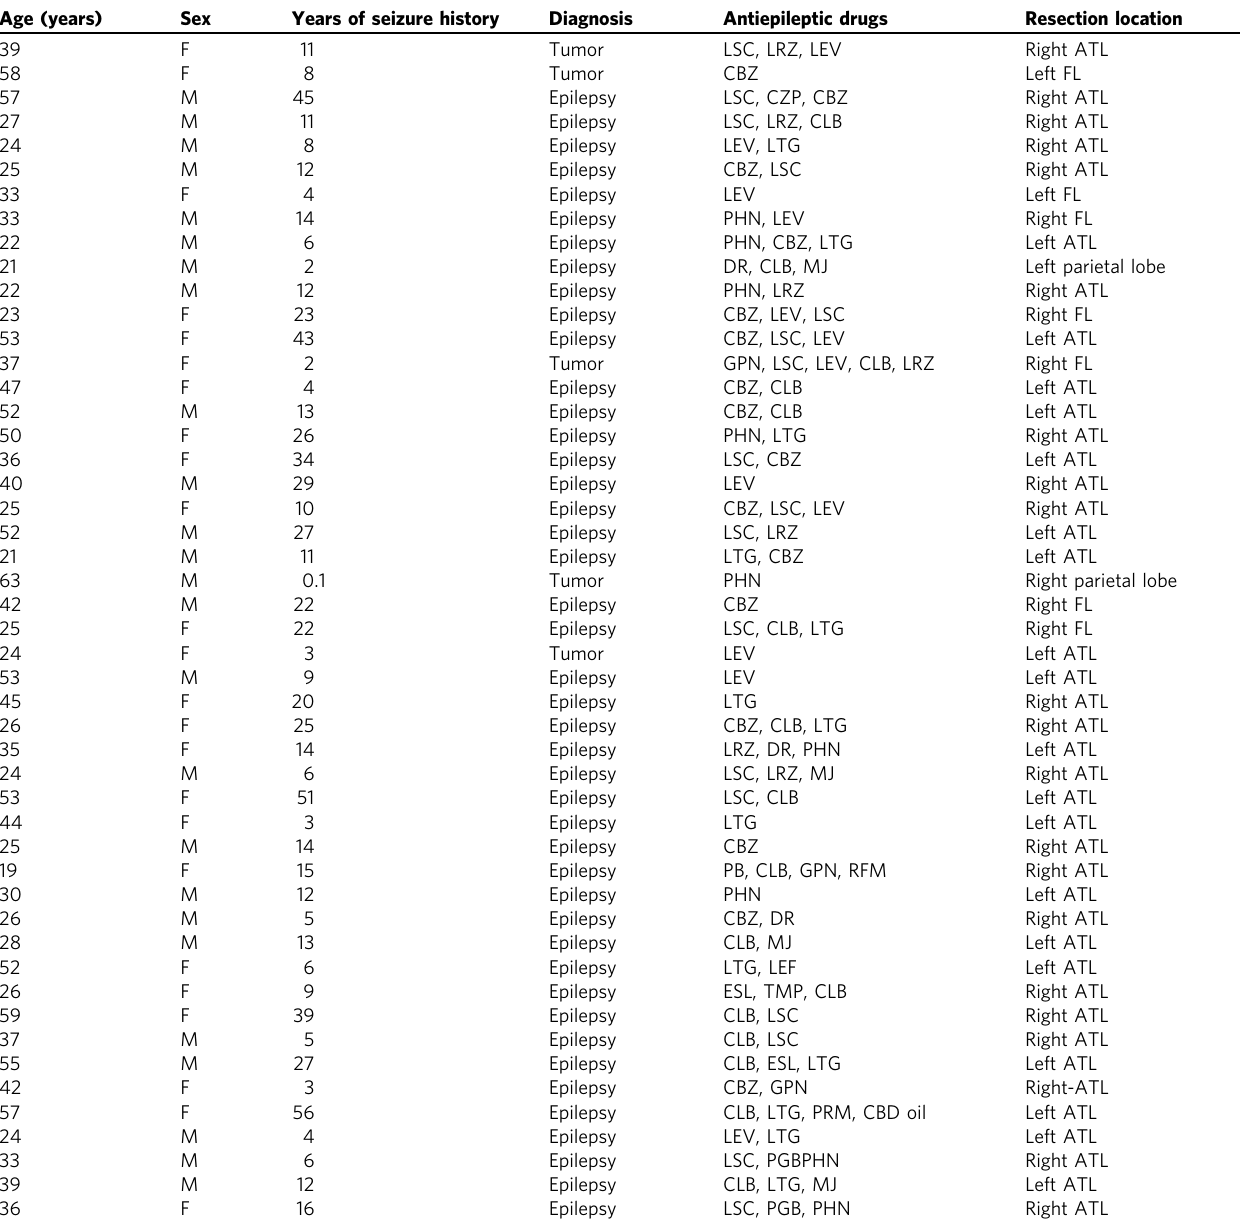
Table 1 Demographic data (for a subset of 49 patients where such information was available). Age